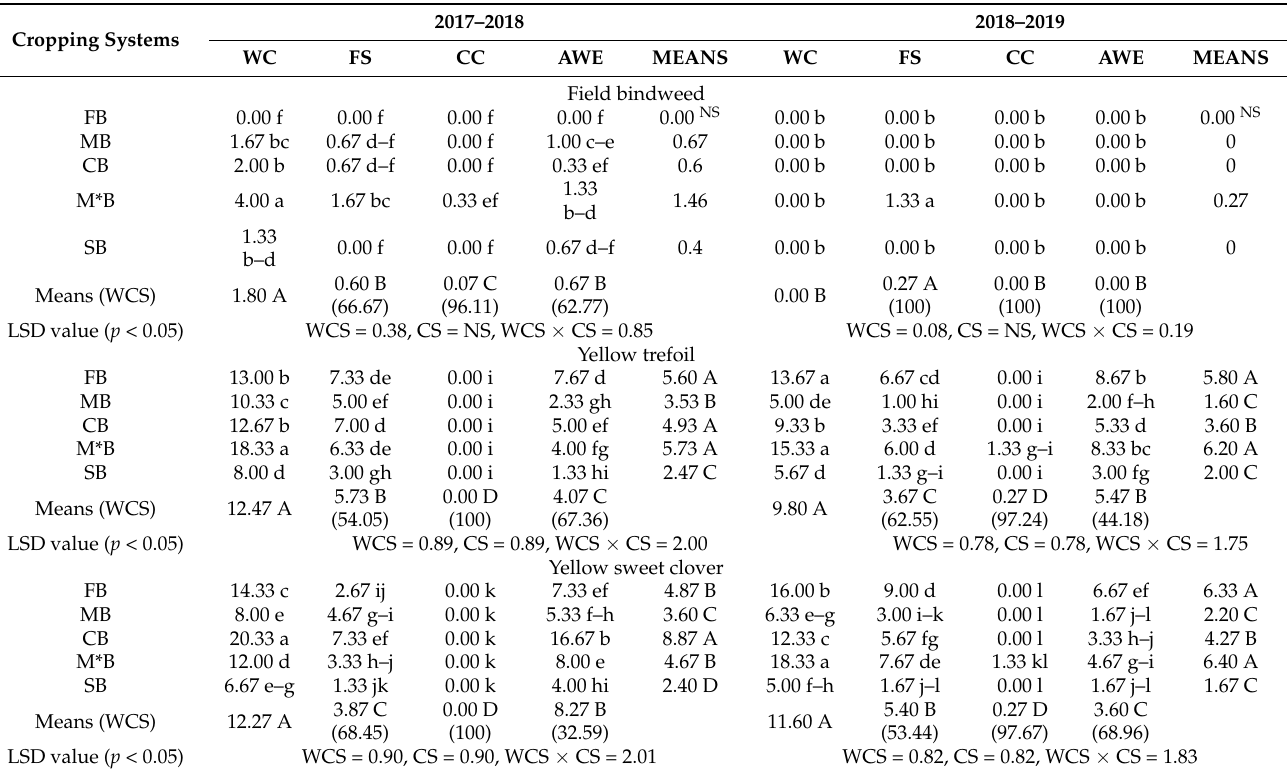
Table 5. Influence of different barley-based cropping systems on individual weeds density (m − 2